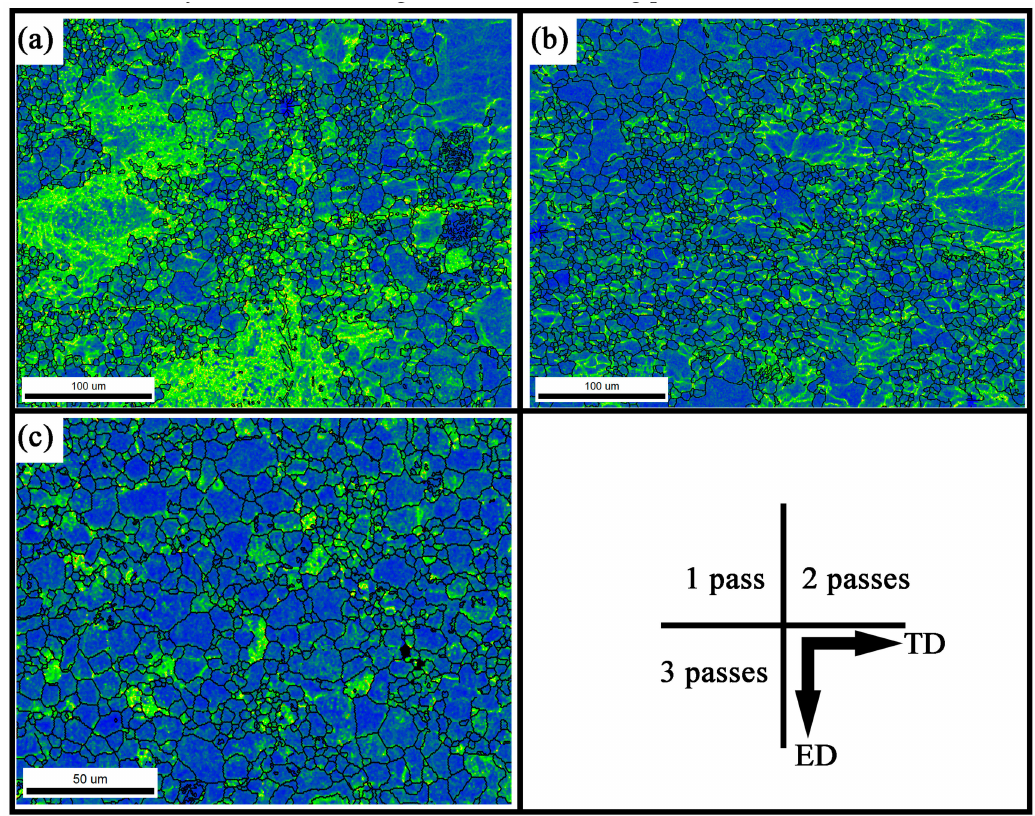
Figure 8. The kernel average misorientation (KAM) maps of ( a ) 1 pass, ( b ) 2 passes, and ( c ) 3 passes of the CEE-AEC-processed